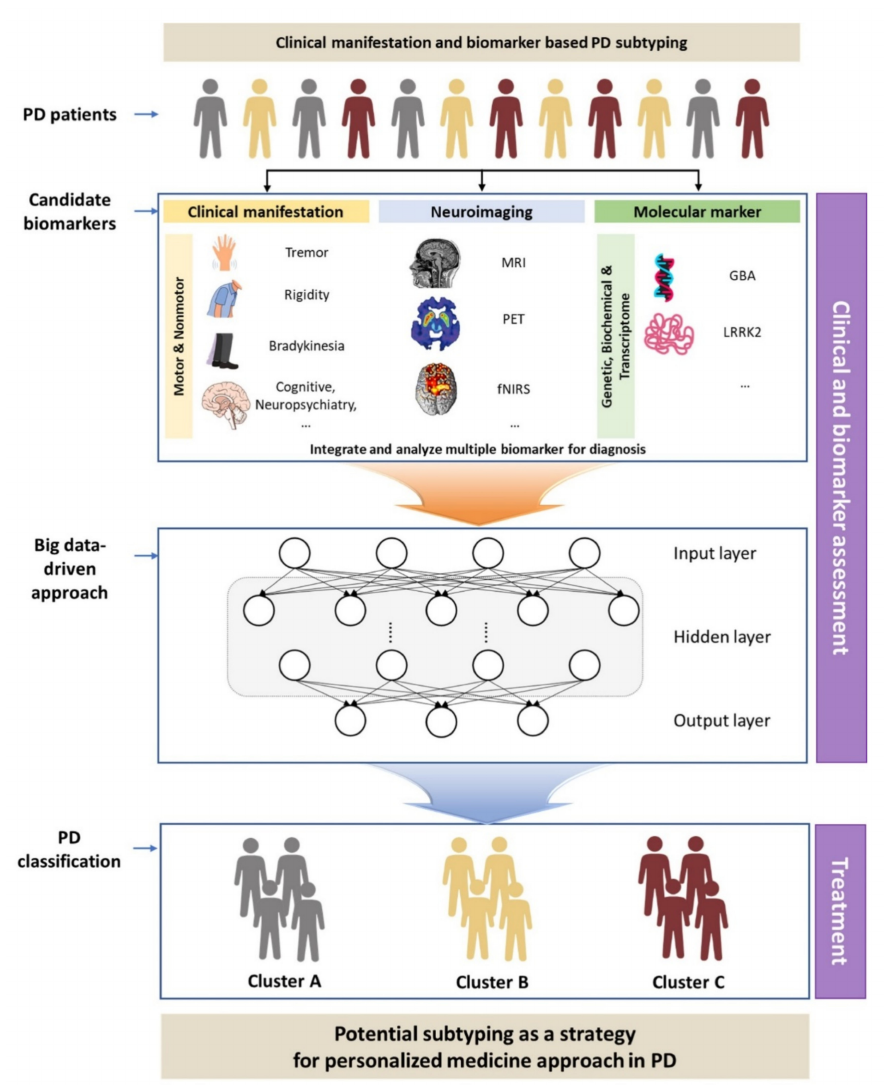
Figure 1. Schematic flow diagram of the classification for subtyping of Parkinson’s disease (PD). MRI, magnetic resonance imaging; PET, positron emission tomography; fNIRS, functional near- infrared